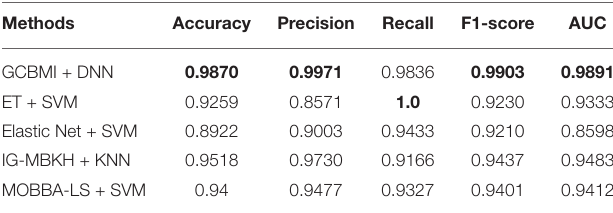
TABLE 2 | Parameter setting. Methods